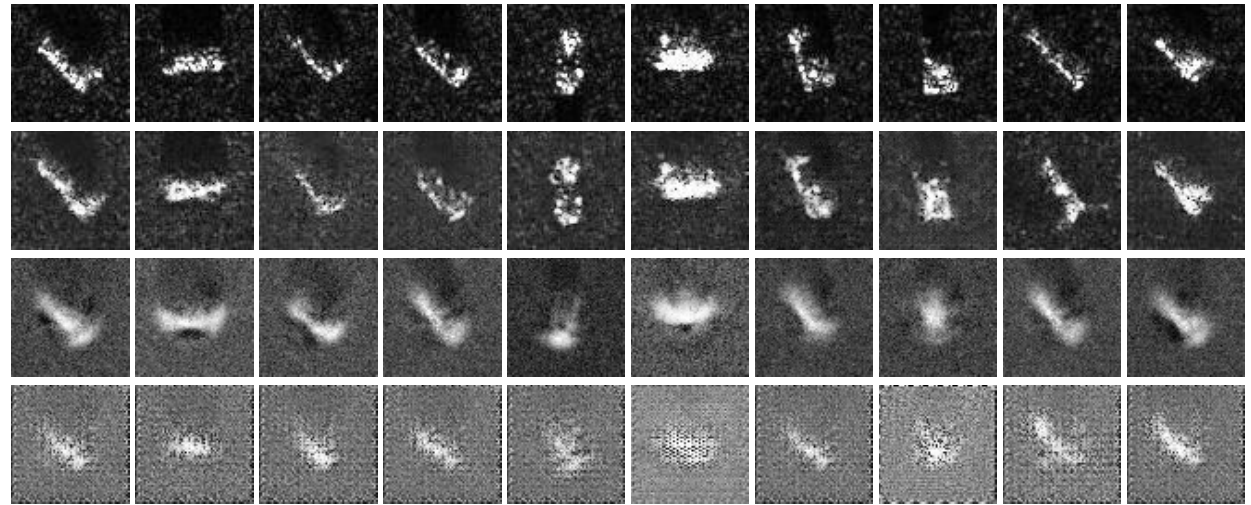
Figure 6. The SAR images of ten categories target samples. According to the order: 2S1, BMP2, BRDM2, BTR60, BTR70, D7, T62, T72, ZIL131, and ZSU23/4. Row 1: the real SAR images of ten categories target samples. Row 2: The SAR images of ten categories target samples generated by the proposed model. Row 3: The SAR images of ten categories target samples generated by conditional GAN. Row 4: The SAR images of ten categories target samples generated by conditional deep convolutional